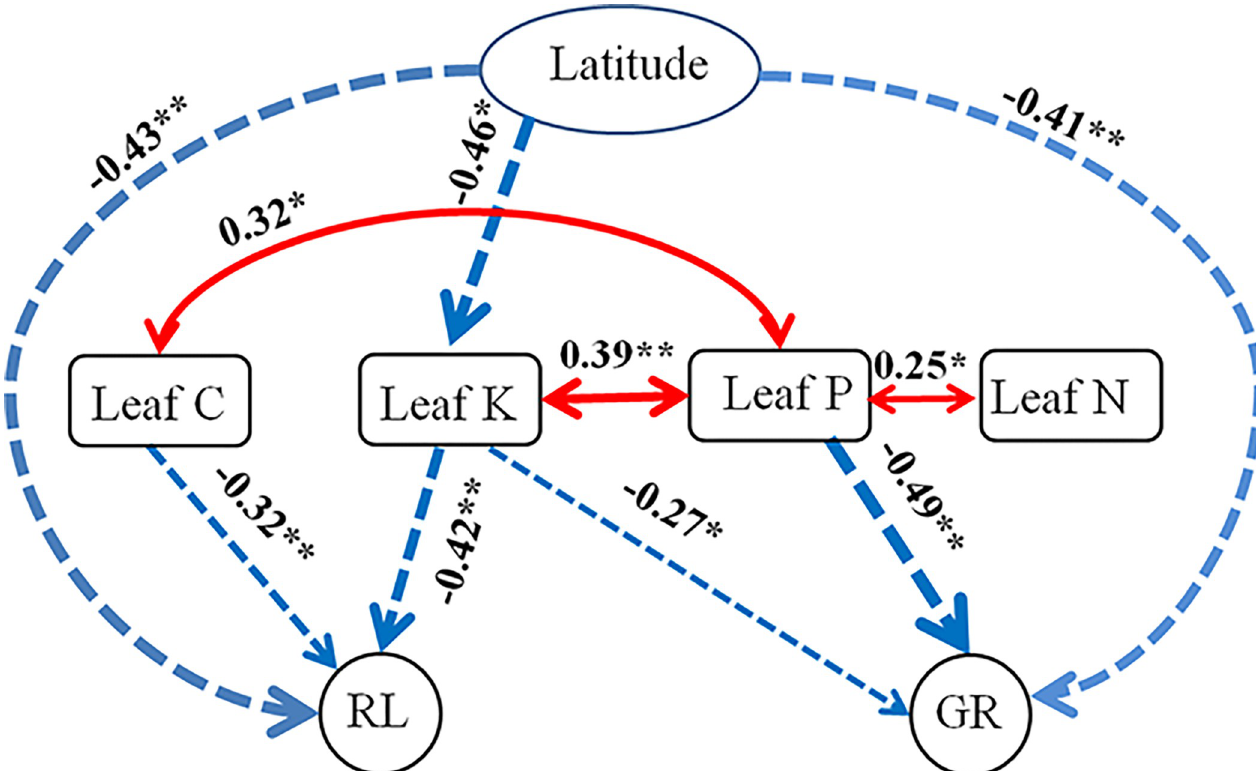
Fig 4. Results of the generalized multilevel path models: Latitude effects plant leaf potassium content (plant K), root length (RL) and germination rate (GR) of the target species; plant K content on RL and GR of the target species; plant leaf carbon content (plant C) on RL of the target species; plant leaf phosphorus content (plant P) on GR of the target species. Only significant paths are presented. Dashed arrows signify negative effects and solid arrows represent positive effects. The width of the arrows denotes the magnitude of standardized path coefficients. ‘ � ’, ‘ �� ’ and ‘ ��� ’ signify p < 0.05, p < 0.01 and p < 0.001,